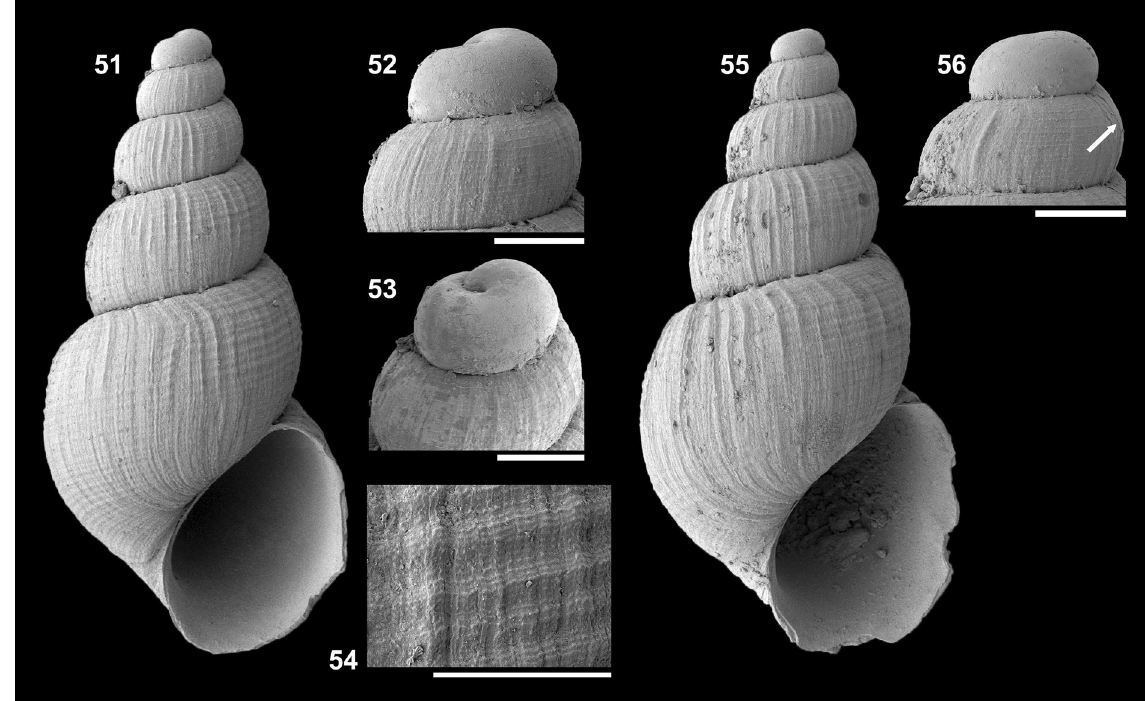
Figs 51–56. Talassia rugosa sp. nov., Angola, Castle Mounds, M122-GeoB20958. 51–54 . Holotype (SMF358973). 51 . Ventral view, H = 3.2 mm, W = 1.6 mm, Ha = 1.1 mm. 52–53 . Protoconch, Wp = 0.34 mm. 54 . Sculpture body whorl. 55–56 . Paratype (SMF358974). 55 . Ventral view, H = 3.2 mm, W = 1.6 mm, Ha = 1.2 mm. 56 . Protoconch, Wp = 0.34 mm, arrow indicates lip. Scale bars = 0.2